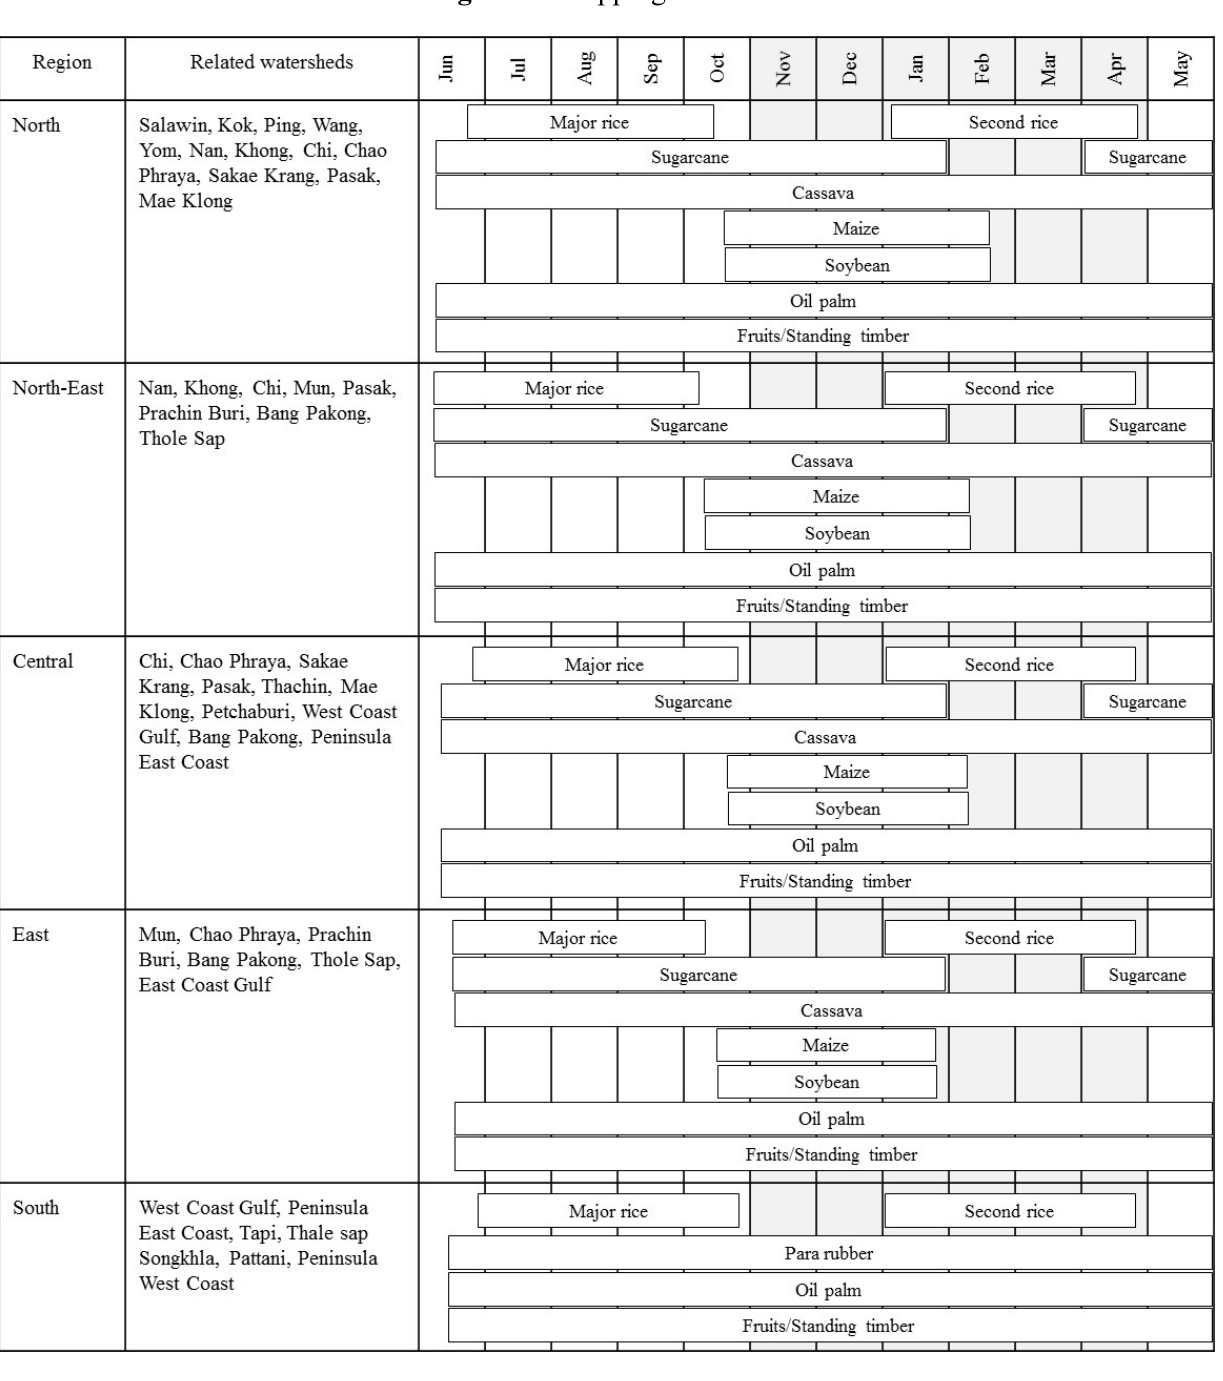
Figure 1. Cropping